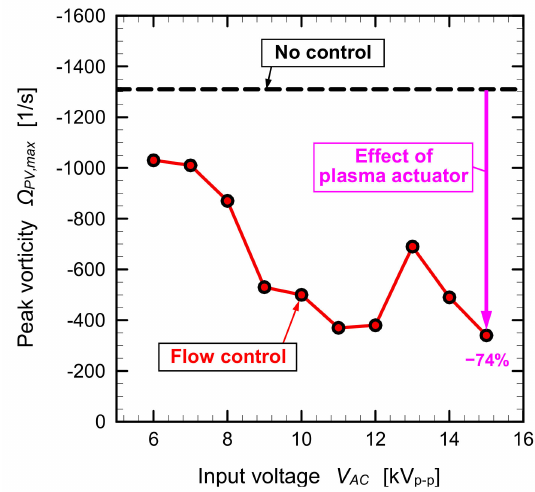
Figure 15. Peak vorticity of passage vortex in center passage ( U FS , out = 2.4 m /